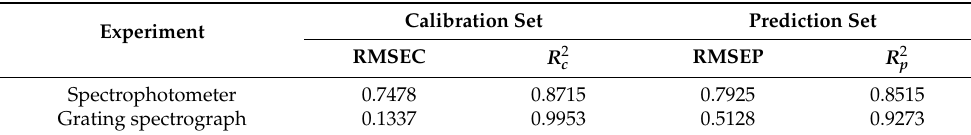
Table 5. Prediction parameters of 1D-CNN models for the spectrophotometer experiment and grating spectrograph